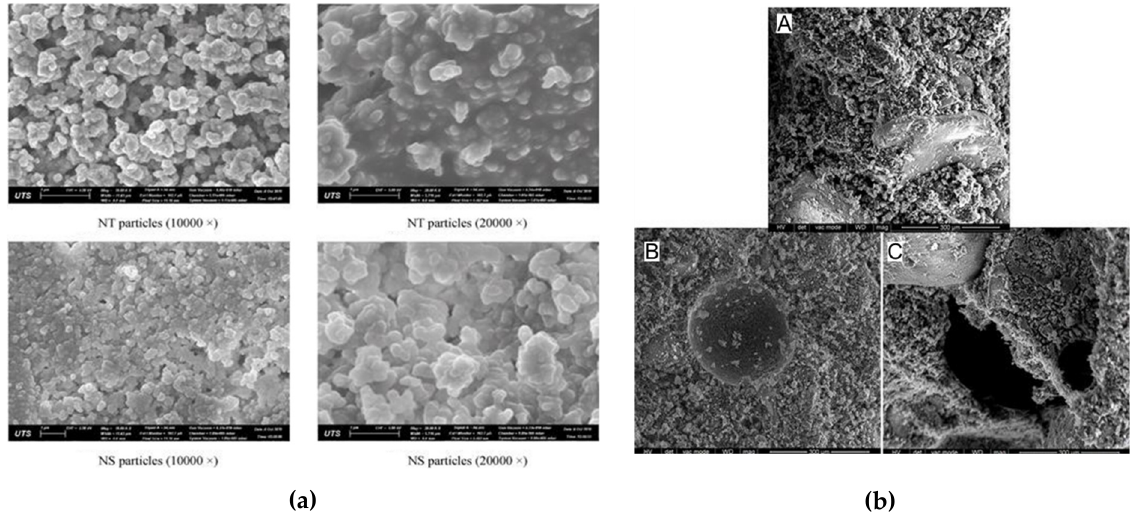
Figure 10. ( a ) SEM images of NT (nano titanium dioxide) and NS (nano silica) morphology of nanoparticles (reproduced Copyright 2022, with permission from Elsevier [74]); ( b ) SEM images of MVCNT with A: 0% MVCNT, B: 0.1% MVCNT, and C: 0.4% MVCNT. (Reproduced Copyright 2022, with permission from Elsevier [21].)